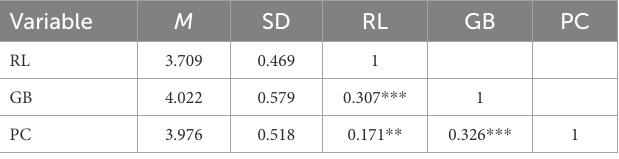
TABLE 1 Variable descriptive statistics and correlation analysis.